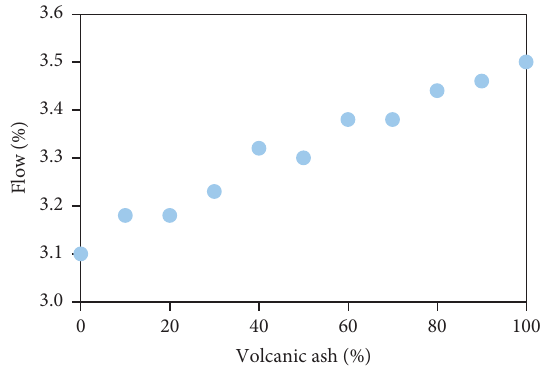
Figure 8: Impact of VA content on Marshall fow of HMA.